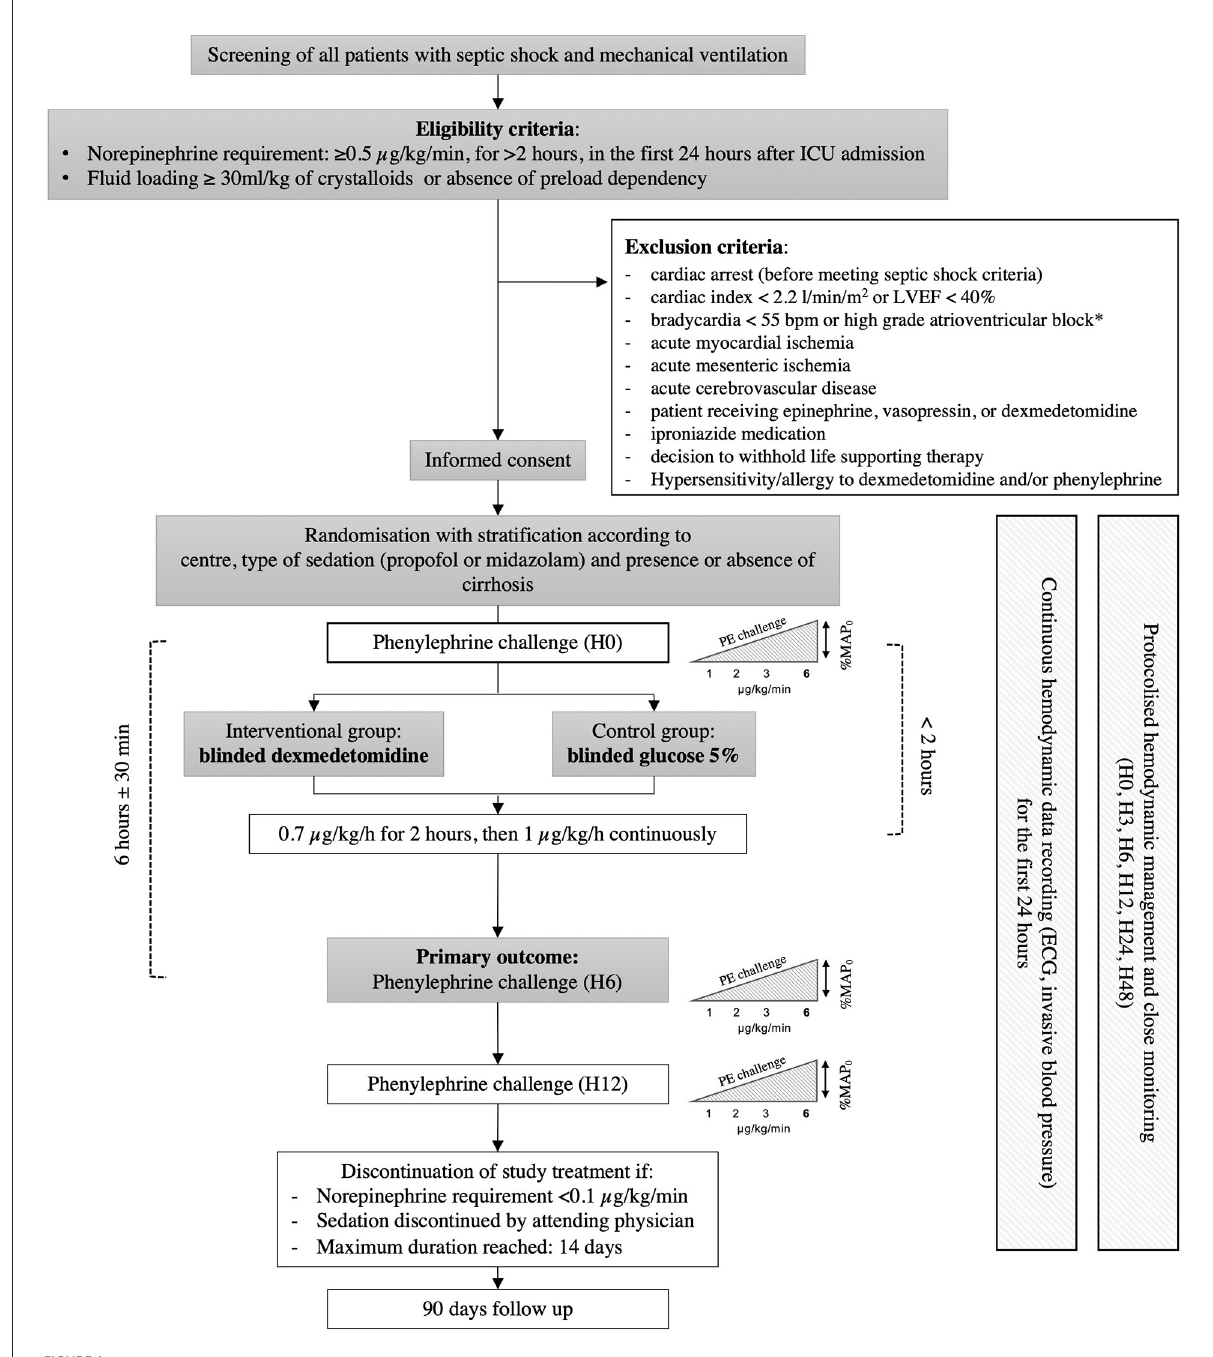
FIGURE1 Schedule of enrollment, interventions, and assessments. ICU, intensive care unit; ECG, electrocardiogram; SAPS II, simplified acute physiology score II; SOFA, sequential organ failure assessment.